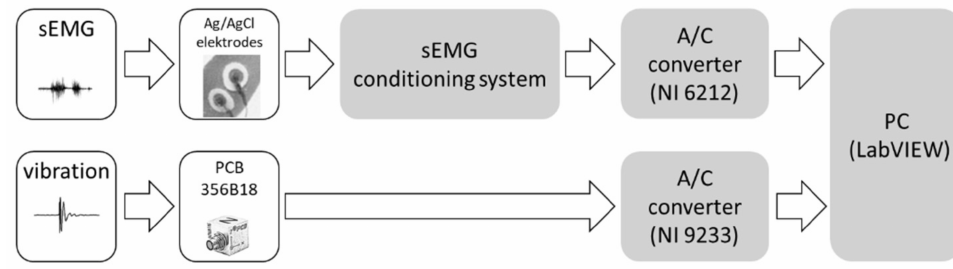
Figure 4. Block diagram of the measuring system.